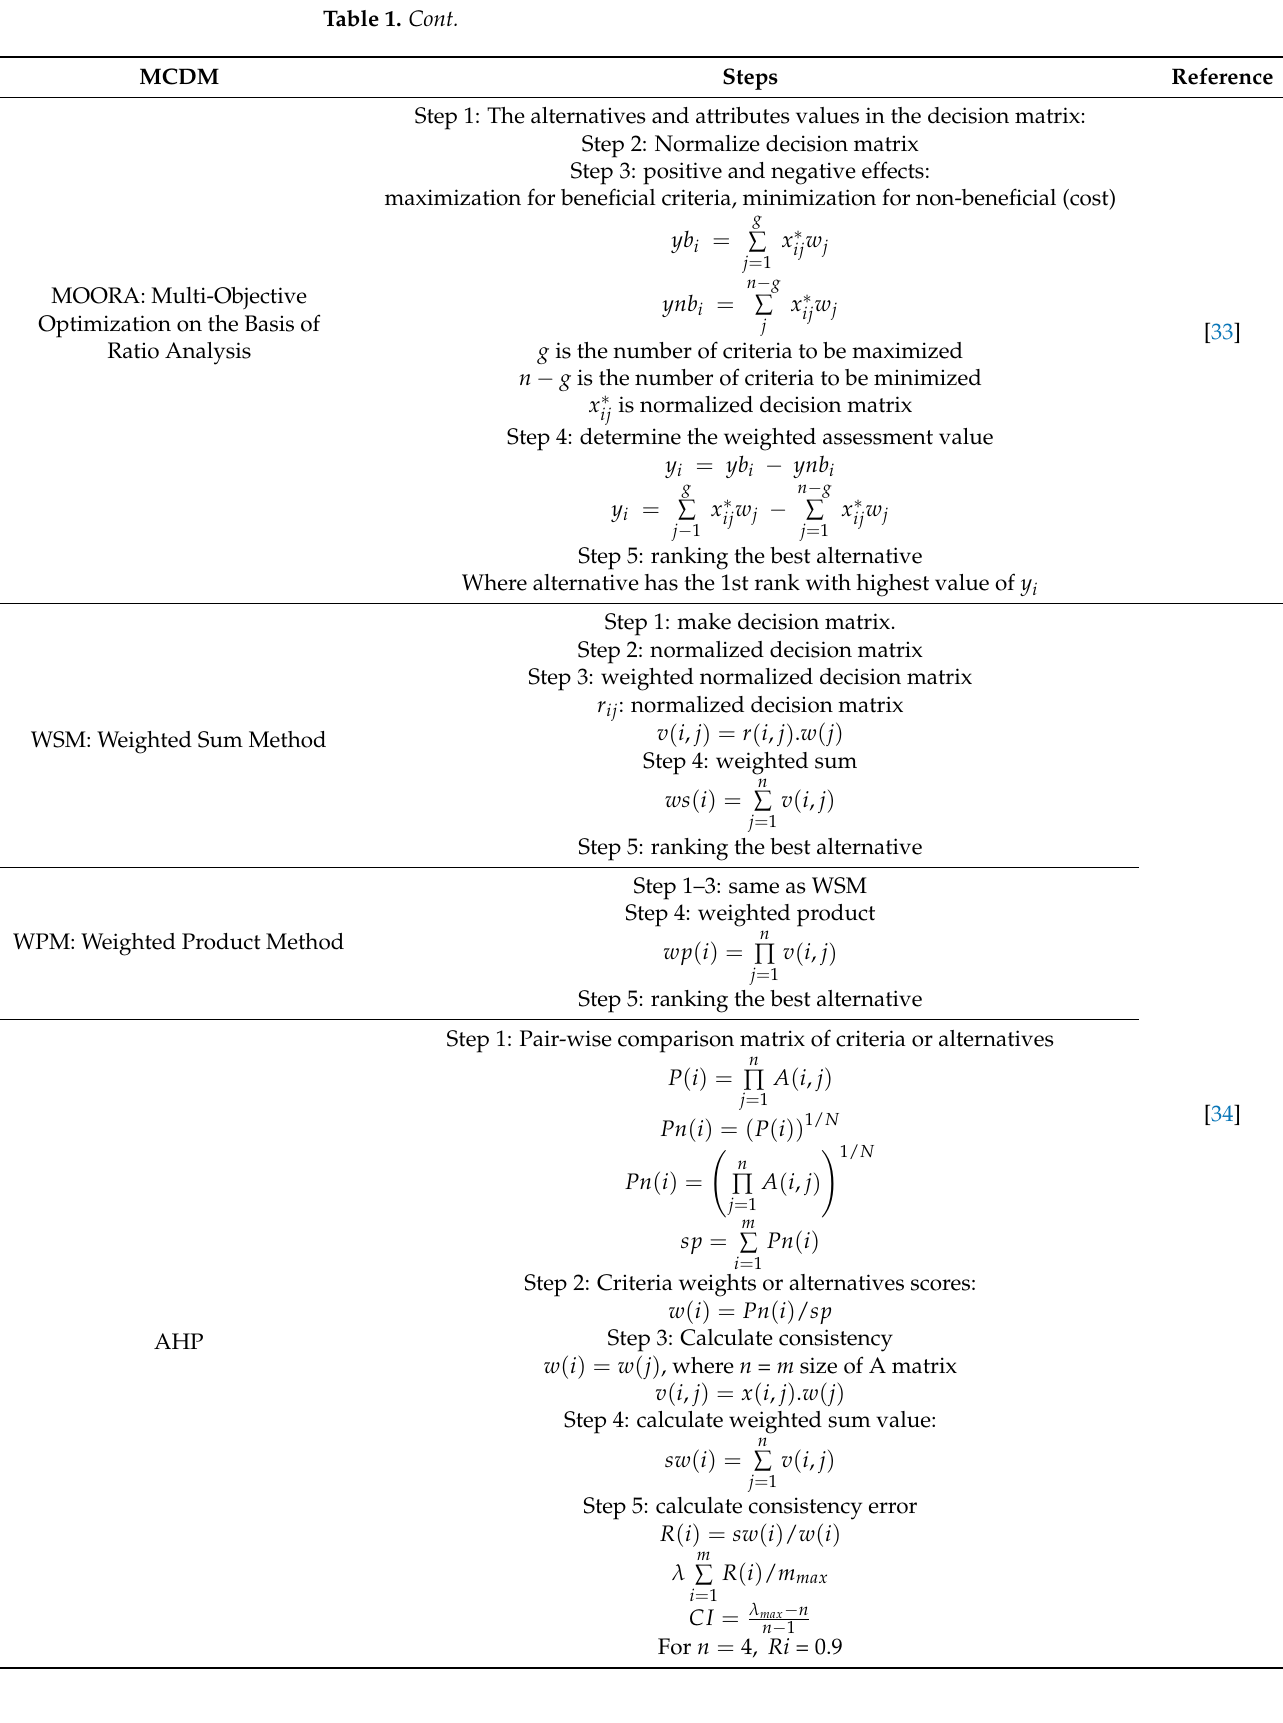
MOORA: Multi-Objective Optimization on the Basis of Ratio